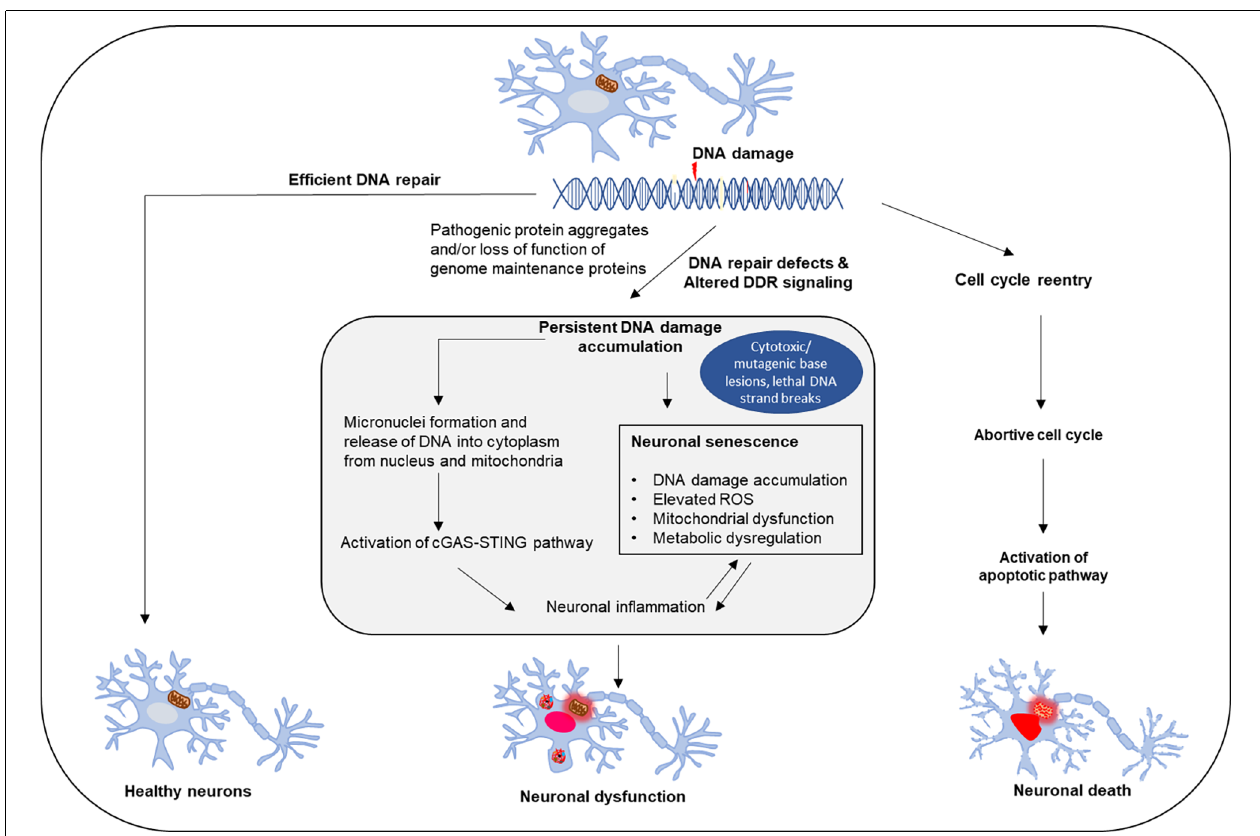
FIGURE 3 | Effect of DNA repair defects on neuronal fate. Neuronal genomes are continuously challenged by damage that occurs frequently due to endogenous or exogenous causes. Healthy neurons require efficient and timely DNA repair, while DNA damage accumulation and repair deficiency induce neuronal dysfunction and degeneration. The consequences of neuronal DNA repair defects and deregulation in DNA damage response include inflammation and neuronal senescence, as well as pathological cell cycle reentry of postmitotic neurons, which triggers apoptosis-mediated neuronal cell